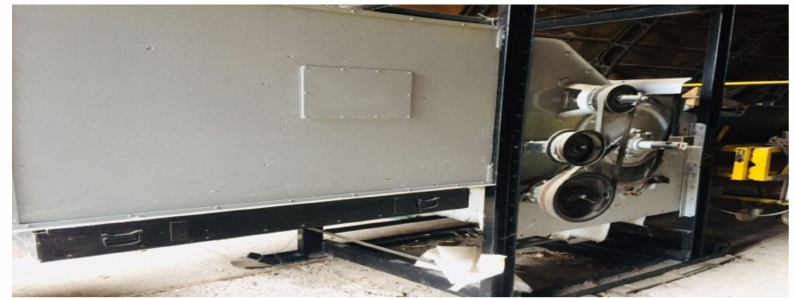
Figure 3. Tangential threshing unit bearing test